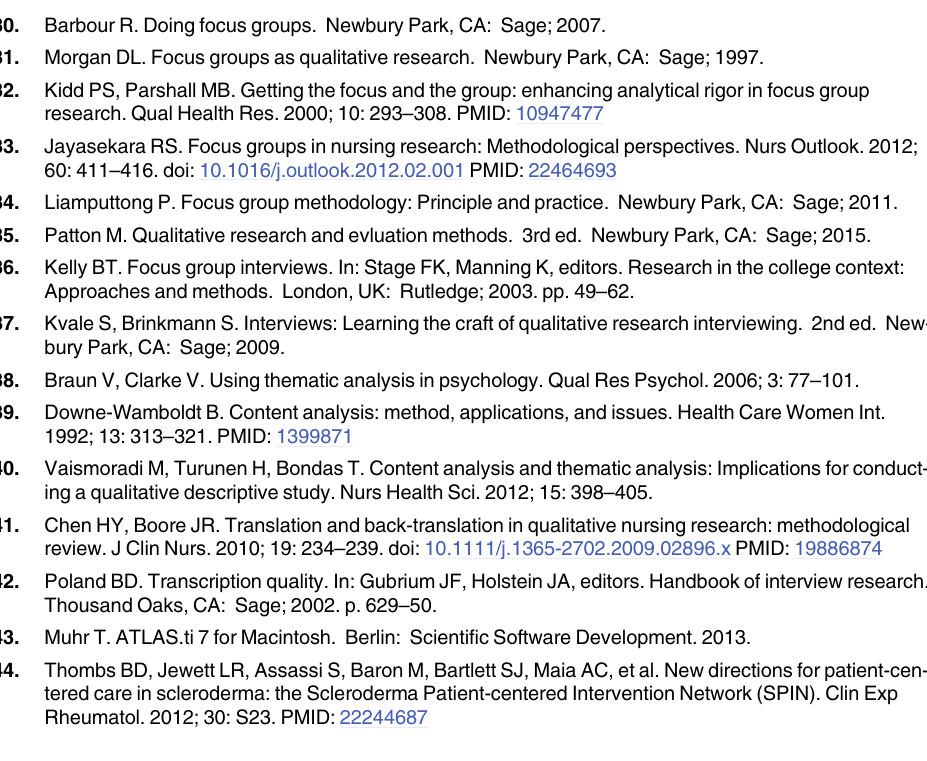
PLOS ONE | DOI:10.1371/journal.pone.0152419 March 23,